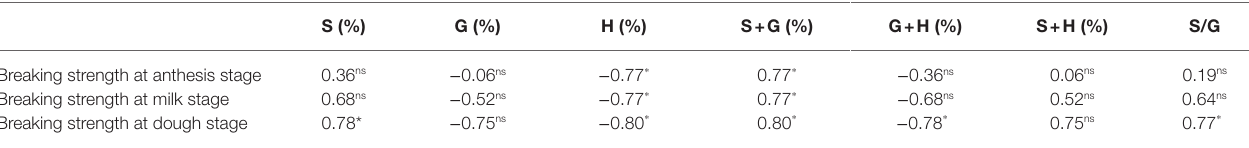
TABLE 5 | The relationship between the breaking strength and the lignin subunit percentage. H, G, and S represent p-hydroxyphenyl lignin, guajacyl lignin, and syringyl lignin, respectively. S (%) G (%) H